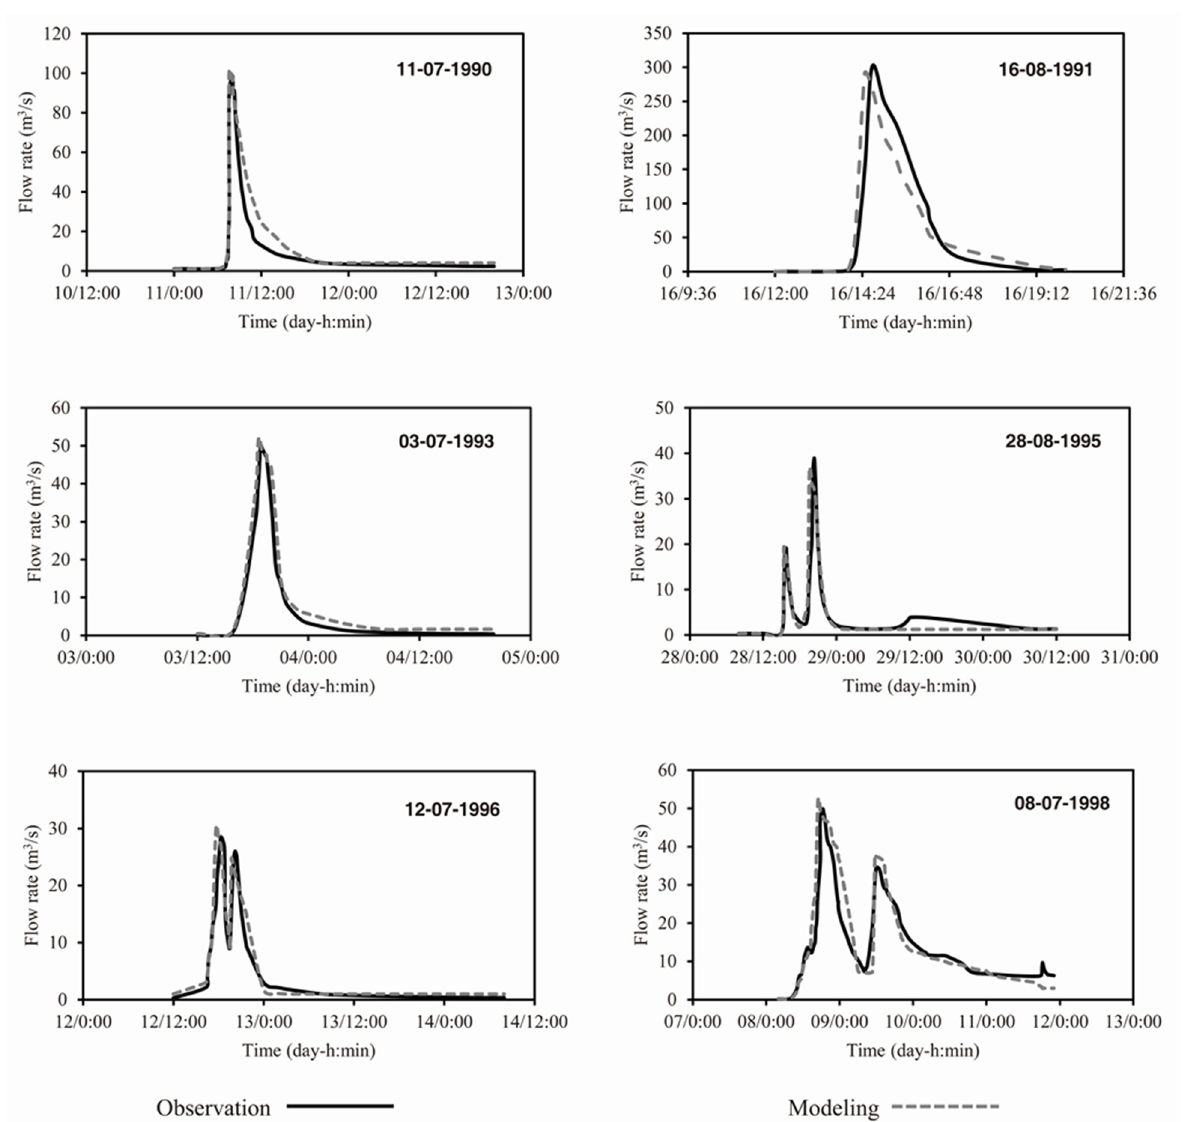
Figure 6. Flow Rate vs Time, Scheme II